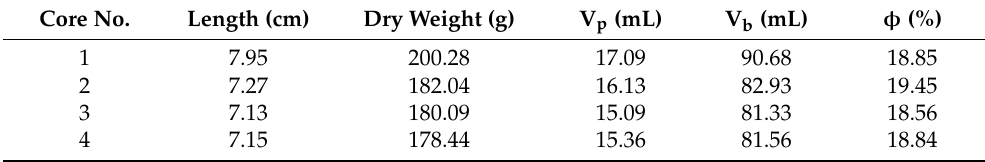
Table 1. Dimensions of the core samples.